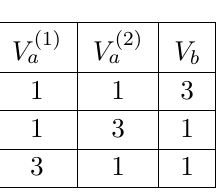
Table 1 . Possible distribution of (cid:12)ve (cid:18) in the vertex operators due to (cid:12)rst three terms of (5.3). means that the contribution of the d (cid:21) (cid:11) C (cid:12) (cid:11) term in the massive vertex operator will require (cid:12) the knowledge of (cid:18) expansion upto O ( (cid:18) 4 ). Thus, we focus here only on the contributions coming from the (cid:12)rst 3 terms in the right hand side of equation (5.3). The possible